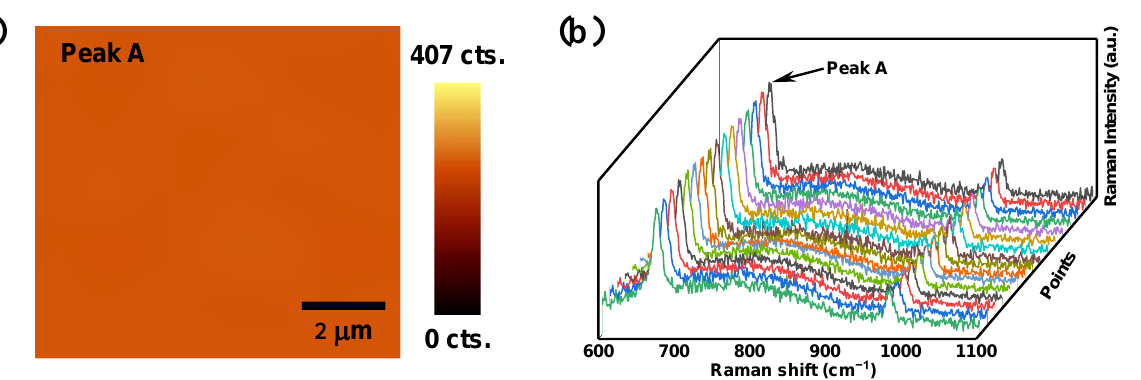
Figure 7. ( a ) Raman mapping of 10 −5 M melamine with the collected signal of peak A at 671 cm −1 . ( b ) Collected Raman signals of 10 −5 M melamine at 16 randomly selected positions within the Raman mapping area.